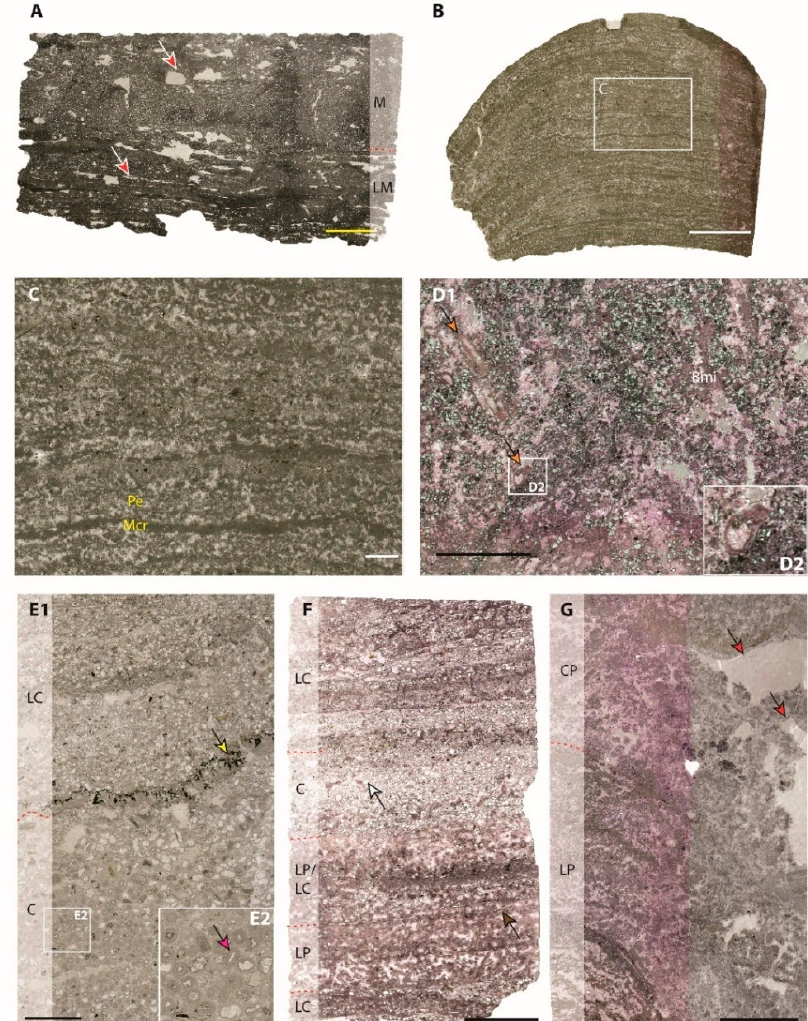
Figure 9. Microfabrics of the Microbialite Association 1 (MA1). ( A ) Section in planar laminites (Pl; Table 1) with a laminated micritic microfabric (LM; Figure 3) passing upward to a micritic microfabric (M; Figure 3) with large fenestral porosity (red arrows). Cariatiz, DS4. The scale bar is 5 mm. ( B ) Section of a medium hemispheroid (H2; Table 1). Cariatiz, DS4. The scale bar is 1 cm. ( C ) Close-up